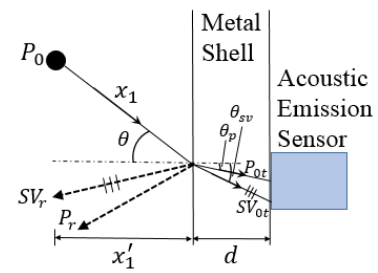
Figure 6. Propagation path of ultrasonic waves.